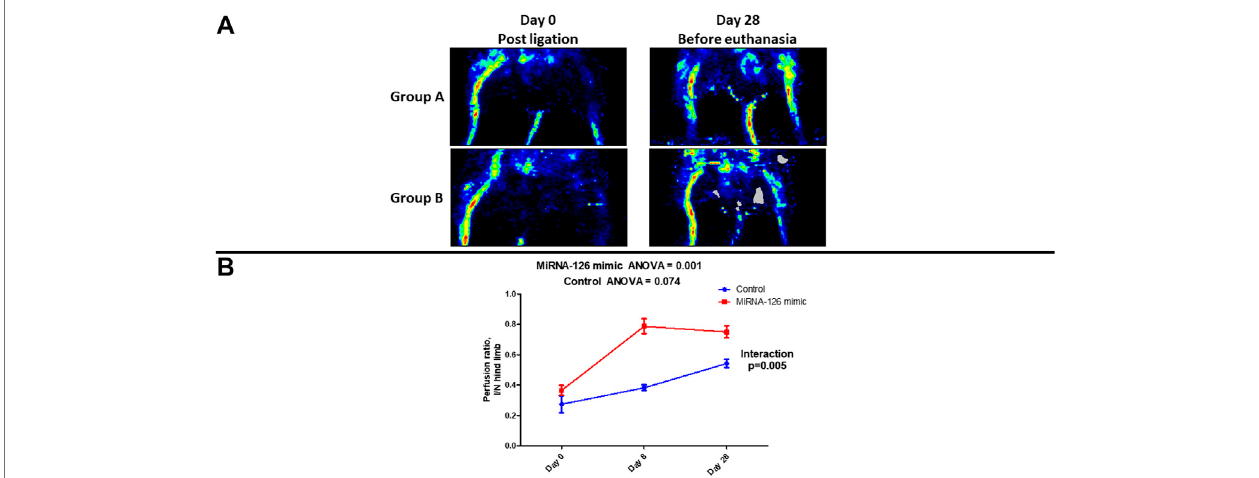
FIGURE 1 | (A) Visual evaluation of laser doppler perfusion imaging examination showing the changes in vascular perfusion of ischemic hind limb after surgical ligation of femoral artery and on the 28th day, following treatment with microRNA-126 mimic (Group A) or microRNA mimic negative control (Group B). (B) Quantitative assessment of changes in the ischemic/normal hind limb perfusion ratio via laser doppler examination showing a higher stepwise improvement in microRNA-126 mimic treated mice, as noted by a statistically signi fi cant p -value for the interaction between study group and ischemic/normal hind limb perfusion